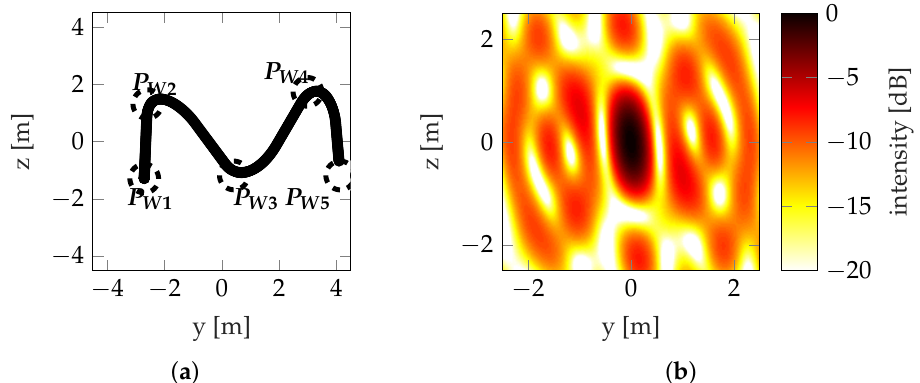
Figure 16. Best final situation—run #1: ( a ) Trajectory with waypoints denoted by P W and acceptance circles marked with a dotted line. ( b ) PSF.